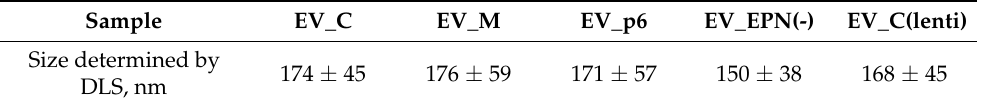
Table 1. The hydrodynamic diameter of EVs. Data were obtained in three biological replicates and indicate the mean diameter ± SD of size distribution estimated by dynamic light scattering, analyzed by t-test. The average diameter of EV_C, EV_M and EV_p6 was different from EV_EPN(-) ( p < 0.01). Sizes of EV_C, EV_M, EV_p6 and EV_C(lenti) were not significantly different. Sample EV_C EV_M EV_p6 EV_EPN(-) EV_C(lenti) Size determined by 174 ± 45 176 ± 59 171 ± 57 150 ± 38 168 ± DLS, nm